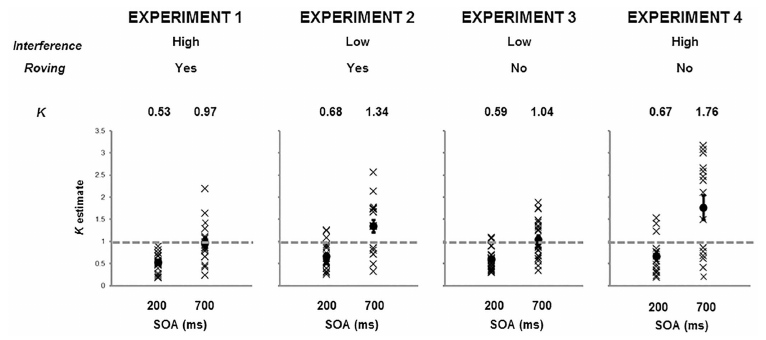
Fig 2. Graph to show variability of audio-visual integration capacity ( K ) for each of Experiments 1–4. Individual participantdata points are indicatedwith an X, conditionmeans are indicatedwith a dot. Error bars depict standard